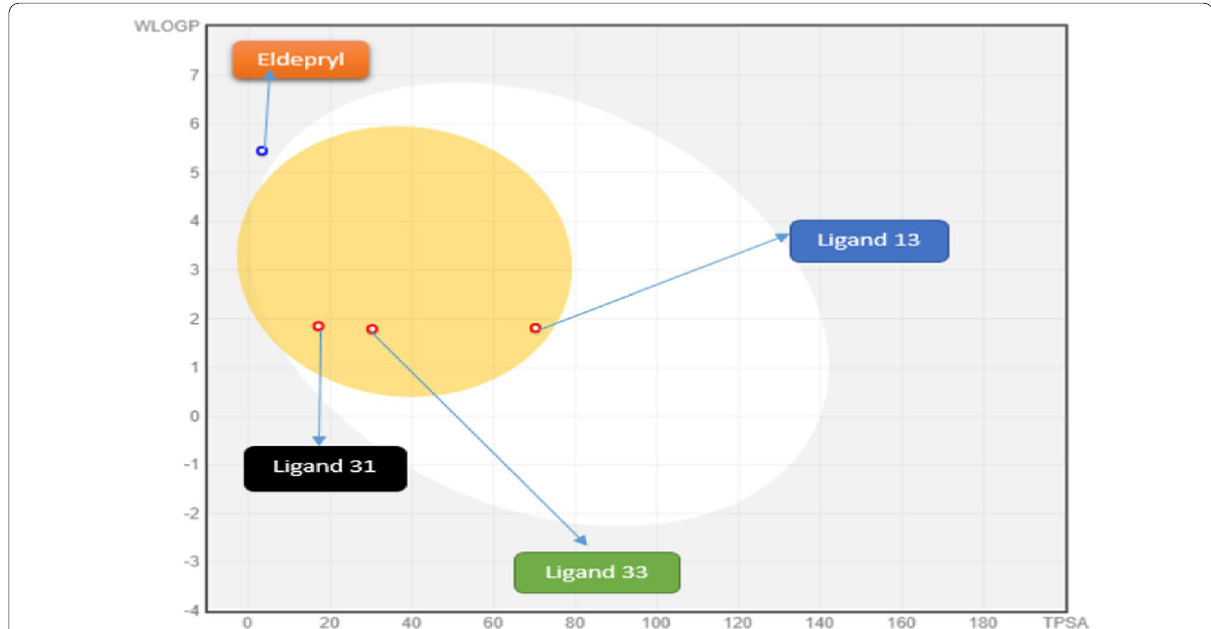
Fig. 11 Model of the most predictive active ligand called BOILED-egg. Molecules 13 (blue), 31 (black), and 33 (green) all fall in the blood–brain barrier. The reference drug (orange) neither falls in the yolk nor